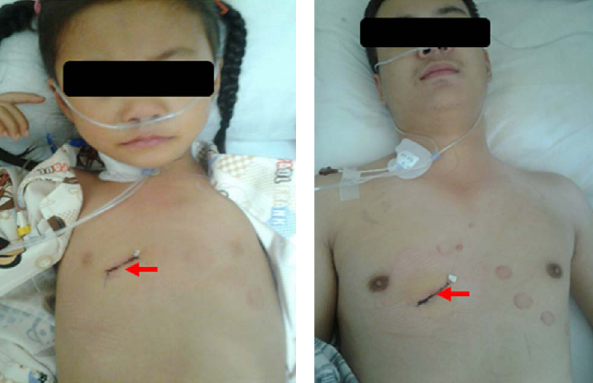
Fig. 2 - Surgical incision in a child (left) and an adult (right), both shown with a red